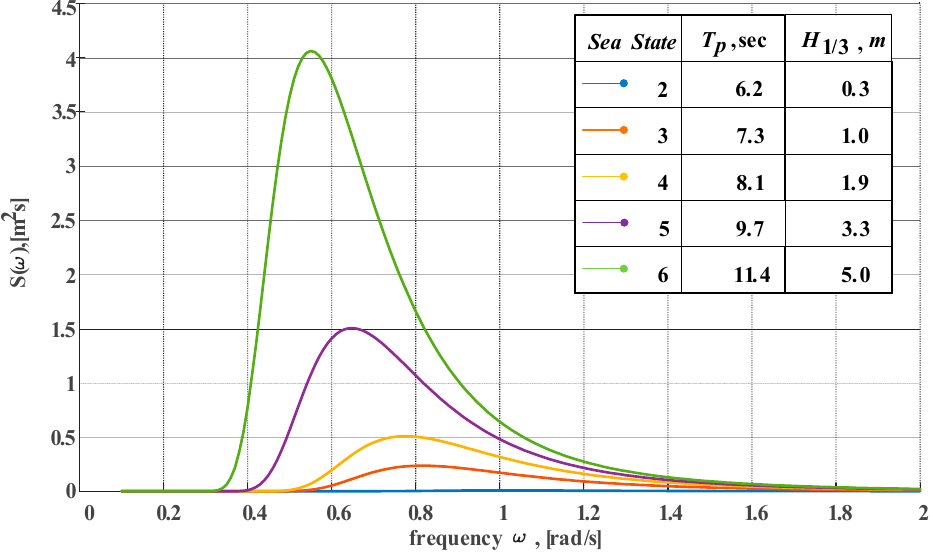
Figure 2. Wave energy spectrum according to Bretschneider model.